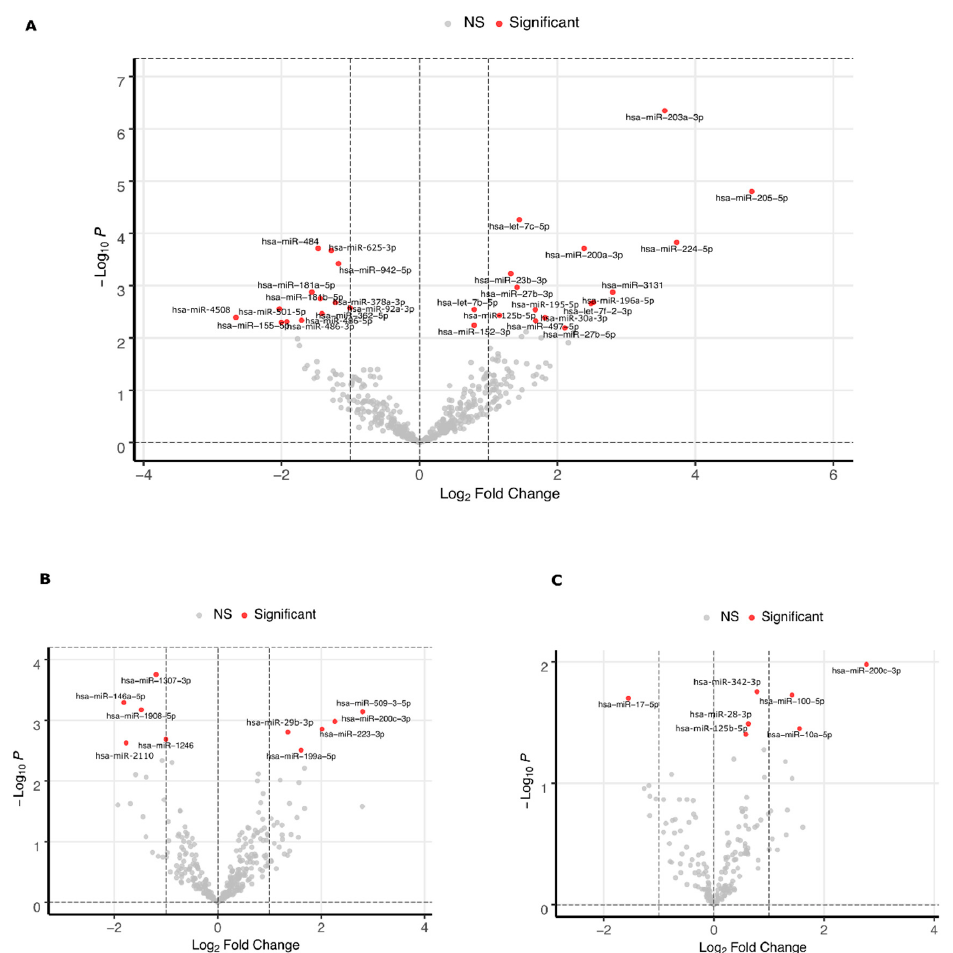
Figure 6. Differentially expressed miRNAs between oocyte donors and PCOS patients in mural granulosa cell samples ( A ), cell-free follicular fluid samples ( B ) and extracellular vesicle samples (C) . Statistical significance cut-off is FDR < 0.1 (A and B) or p < 0.05 ( C ).